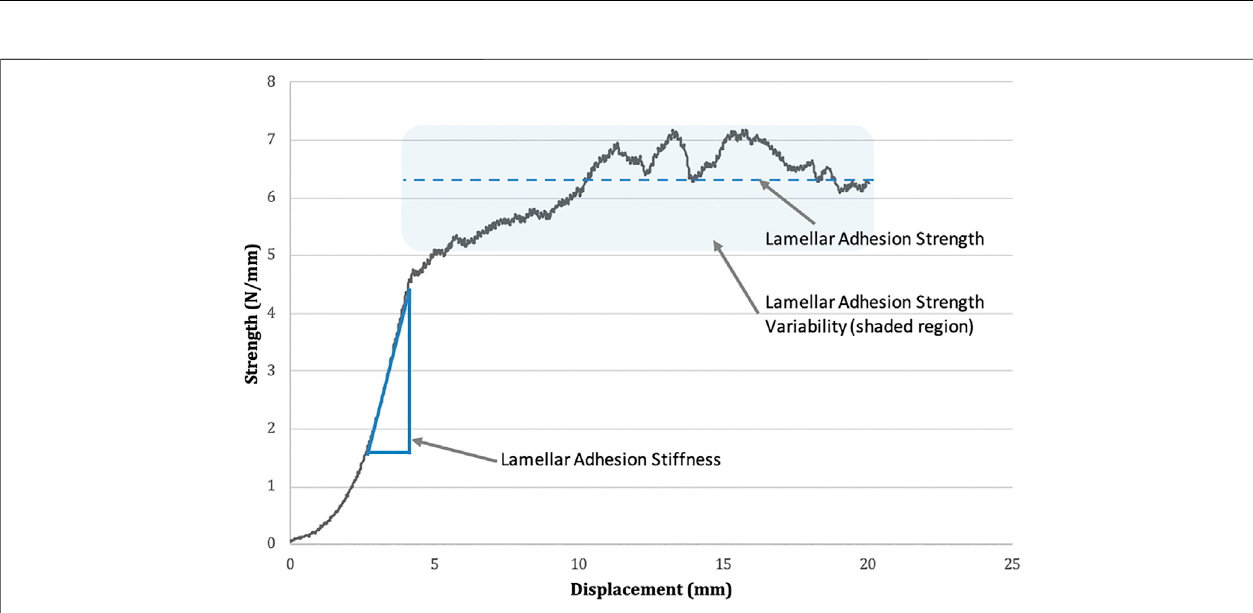
FIGURE 2 | Lamellar adhesion strength-displacement curve. Mean lamellar adhesion strength is represented by the dotted line. The standard deviation of lamellar adhesion strength isrepresented bytheshaded areaabove and belowthe lineofthe mean(termedlamellar adhesion variability). Lamellar adhesion stiffness isindicated as the slope of the linear region of the